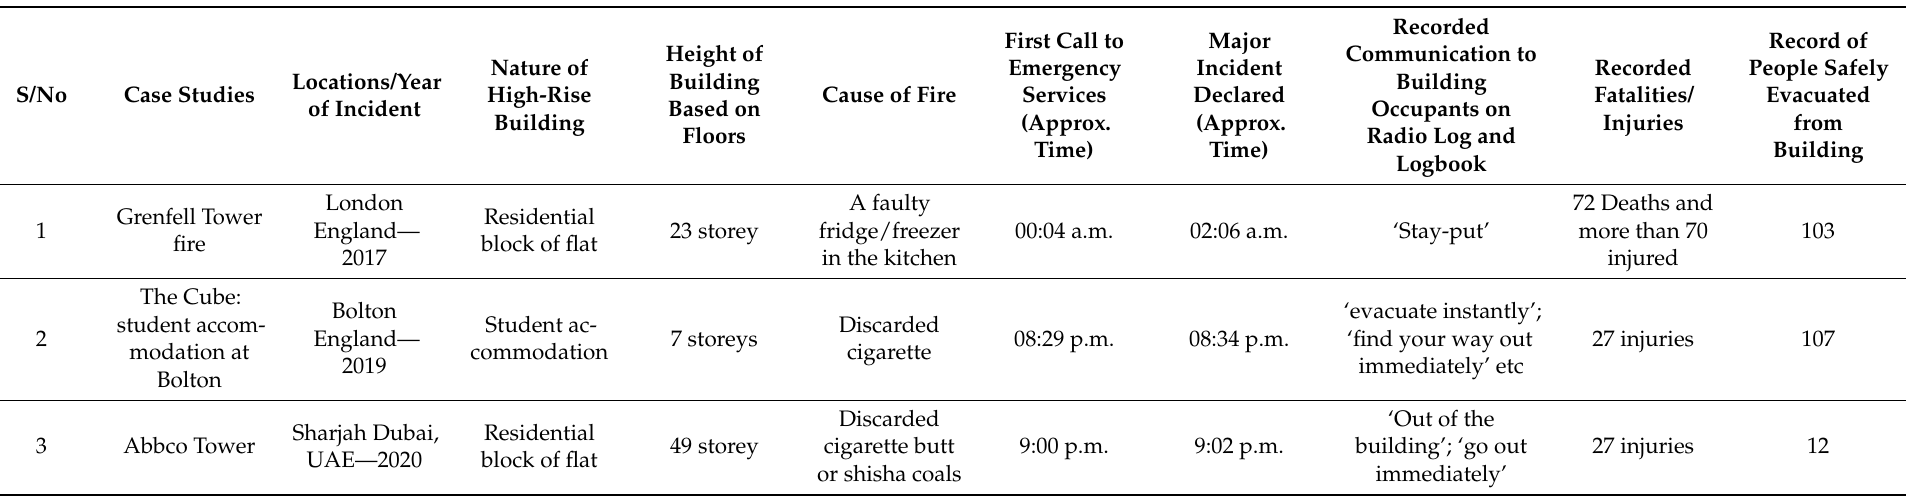
Table 1. Summary of three case studies of fire in high-rise buildings.